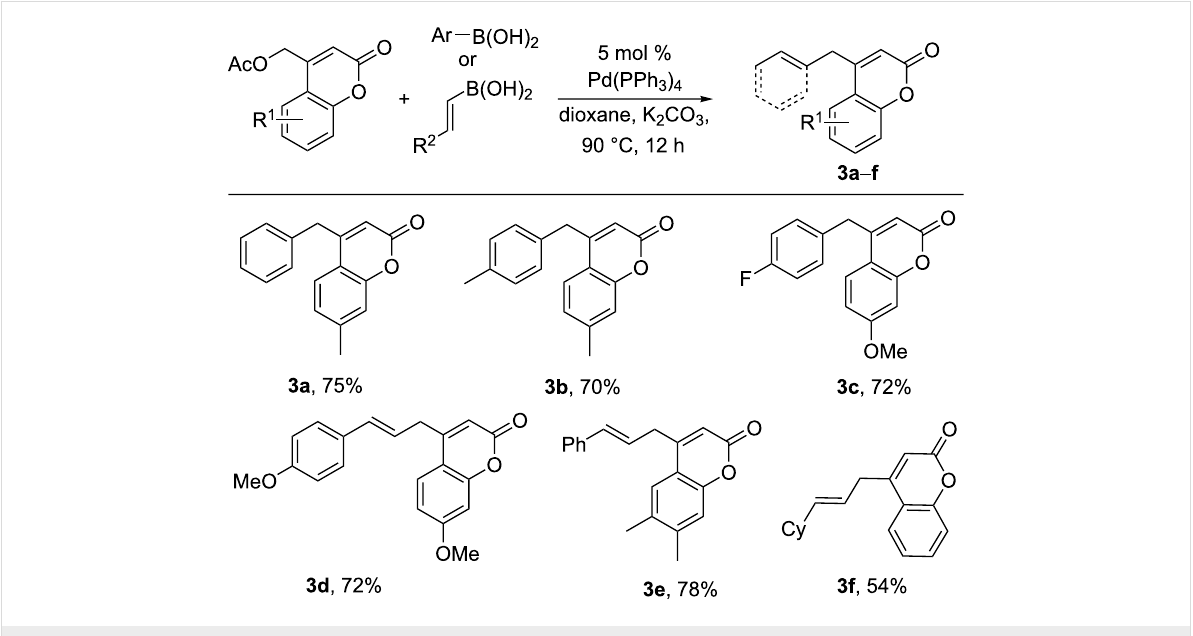
Scheme 3: Scope of Suzuki-coupling of coumarinyl